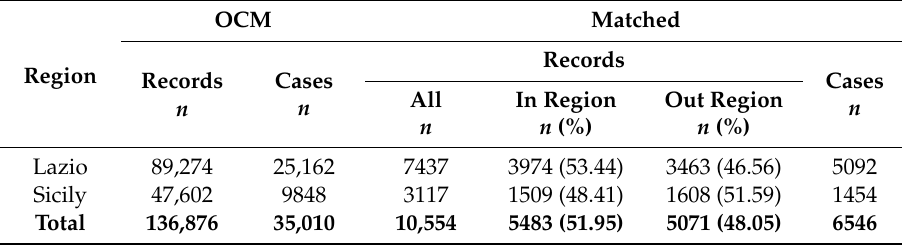
Table 7. The number of OCM records and cases for Sicily and Lazio. The number of linked records was divided into the records identified using the information from the region (in region) or the dictionary records from the other regions (out